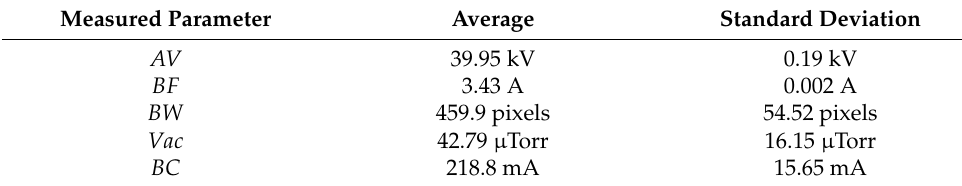
Table 1. Measured values and standard deviations of the print conditions.